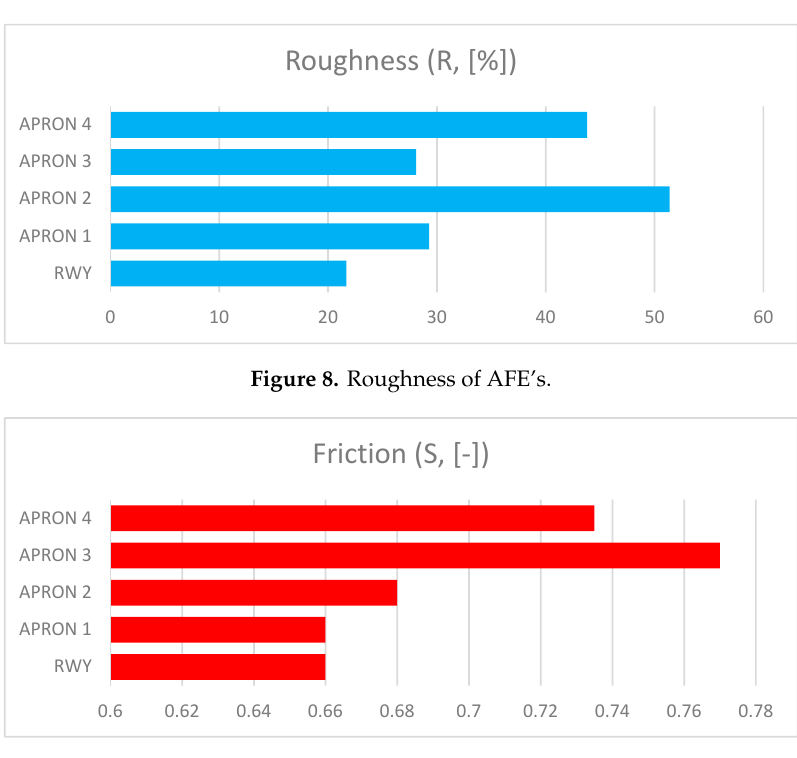
Figure 7. Pavement Classification Number of AFE’s.